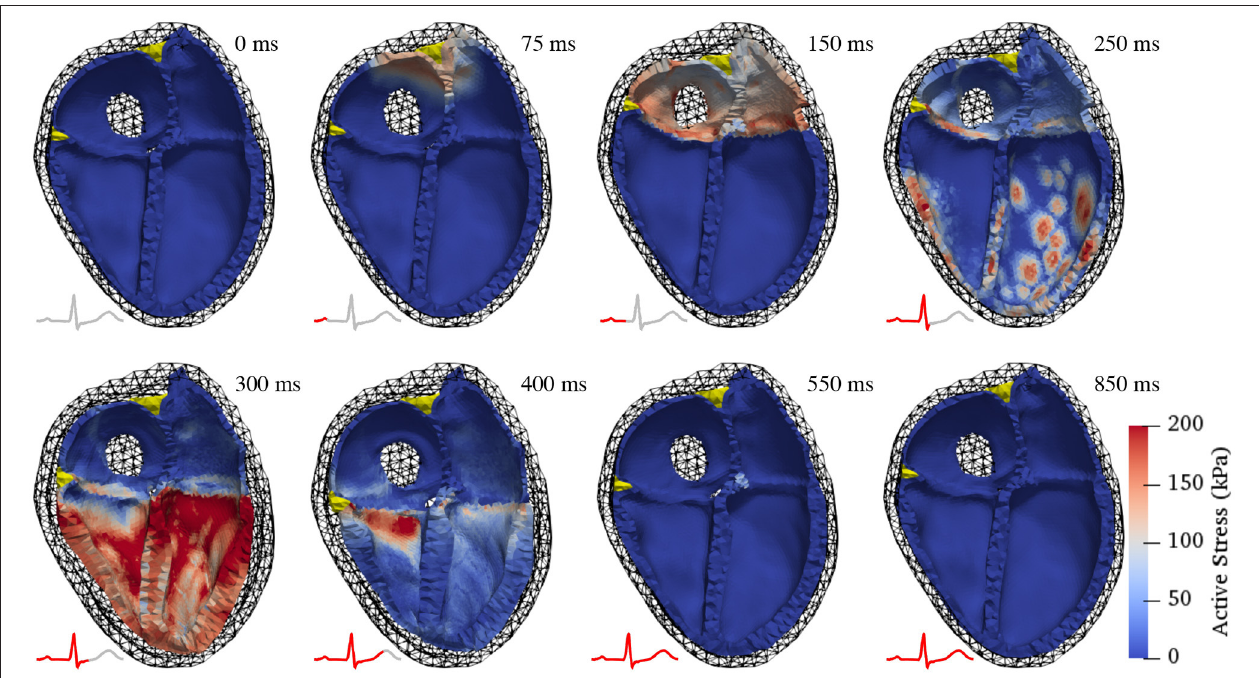
FIGURE 5 | Deformation during a complete cardiac cycle. At first, the atria contract, pulling the atrio-ventricular valve plane upwards and increasing the volumes in the ventricles (150ms). Subsequently, the ventricles contract isovolumetrically causing a rapid pressure increase (250ms). Once the ventricular pressure surpasses the respective arterial pressure in the outflow vessels, the ejection phase begins (300ms), characterized by noticeable thickening of the ventricular walls. Ventricular pressure then drops as the ventricles start relaxing, initially without changes in volume (400ms). After ventricular pressure has decreased below atrial pressure, the ventricles relax back to their initial state and passively re-fill to 85% of end-diastolic volume during early diastasis (550 and 850ms). Color coding shows active stress (the force generated by contracting cardiac myocytes). Juxtaposed ECG traces show the temporal relationship of the displayed contraction states with electrical